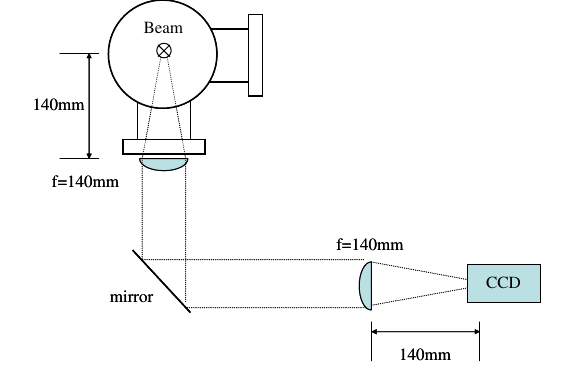
FIG. 8. A rough sketch of the horizontal beam-size measure- ment system. The main components of the system are a CCD camera, two focusing lenses, and one